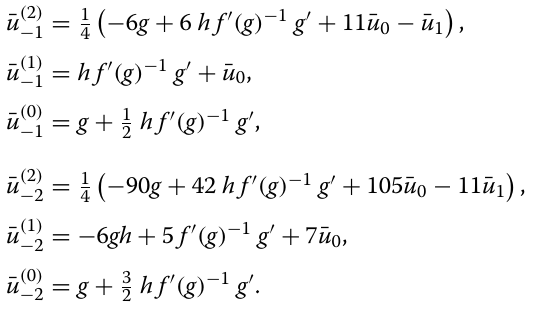
P 4 Apply this algorithm for the simulation of turbulence flows and other engineering